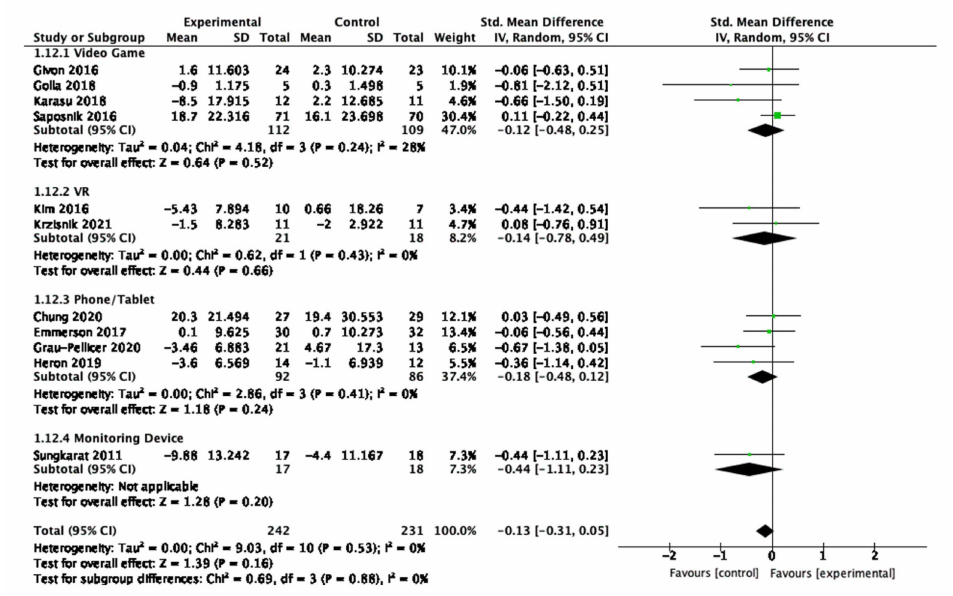
Figure 10. Subgroup analysis for the type of digital interventions that measured sedentary behaviour outcomes.